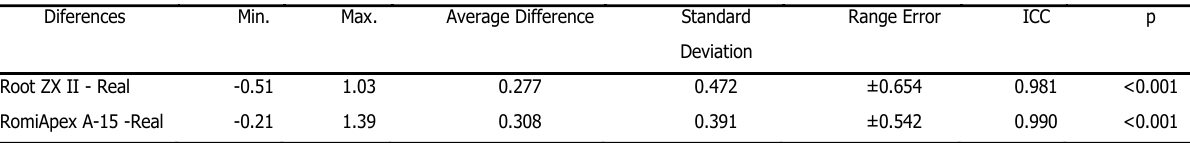
Table 1. Data obtained after the comparison between the differences in measurement of electronic apex locators Root ZX and Romiapex A-15 and real